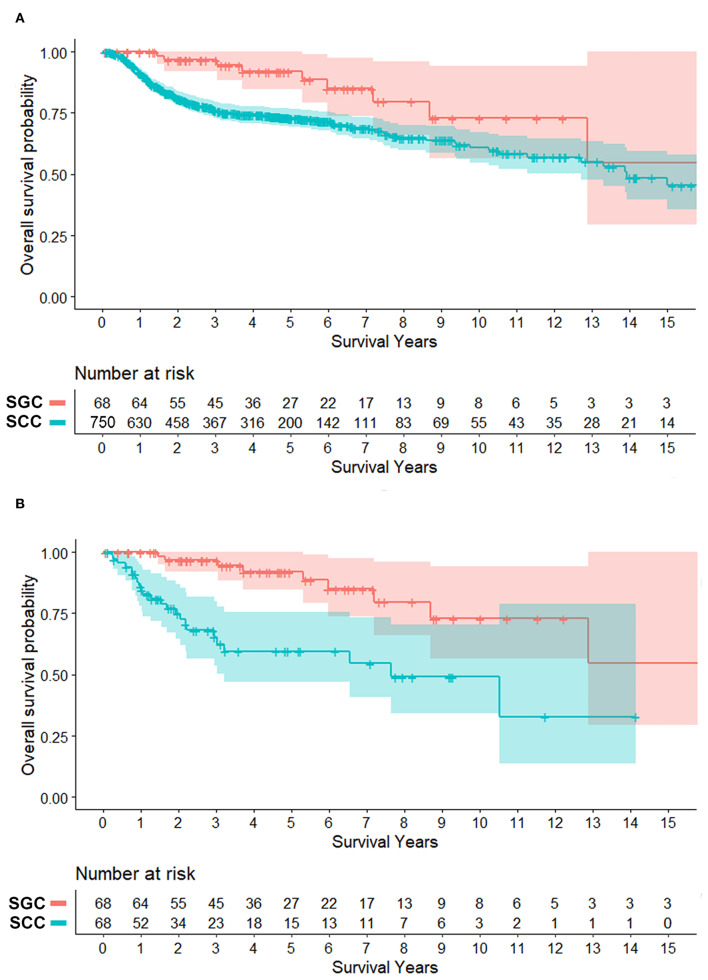
Survival plots of patients with minor salivary gland cancer (SGC) and mucosal squamous cell carcinoma (SCC) in the oral cavity (overall survival). (A) Total patients. (B) Patients matched for tumor size (T status) and subsite (propensity score, 1:1). Shaded area = 95% confidence interval. Overall survival rates at 5, 10, and 15 years for oral SGC were 91.9, 72.9, and 54.7%, respectively. Those for oral SCC were 73.2, 61.8% and 48.6% (N = 750) and 59.6, 49.1, and 32.8% (N = 68 in matched cases).